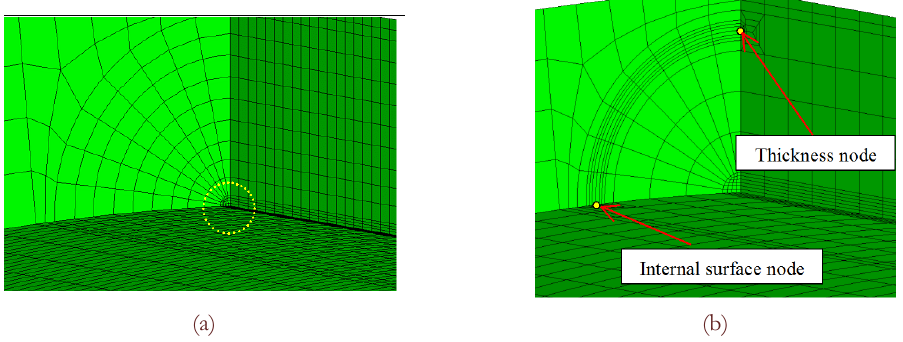
Figure 6: FE model used in the crack propagation analysis: (a) mesh without crack; (b) mesh with crack and position of nodes of interest. The Thickness node will degenerate into the External Surface node while reaching the external